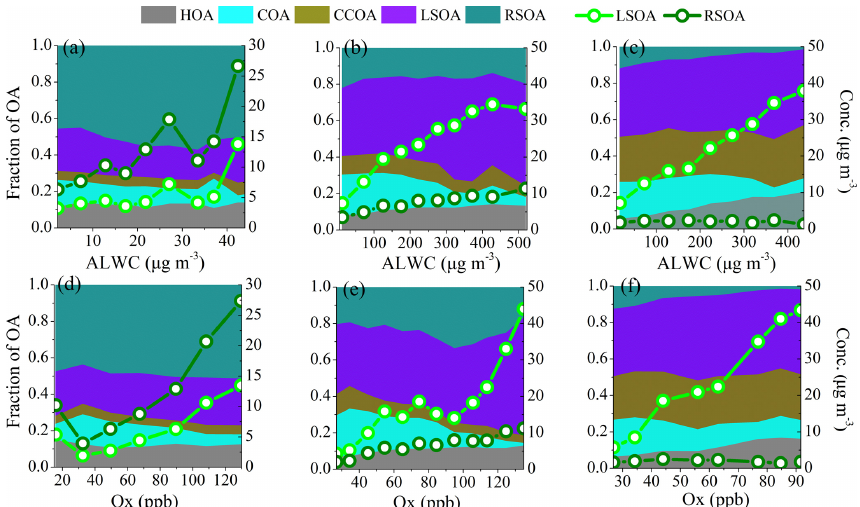
Figure 7. Variations in the mass fractions and mass concentrations of LSOA and RSOA as functions of ALWC or O x in (a, d) late summer, (b, e) autumn and (c, f) early winter. The data were binned according to the ALWC concentration (5µgm − 3 increment in late summer, 50µgm − 3 increment in autumn and early winter) and O x concentration (20ppb increment in late summer, 10ppb increment in autumn and early